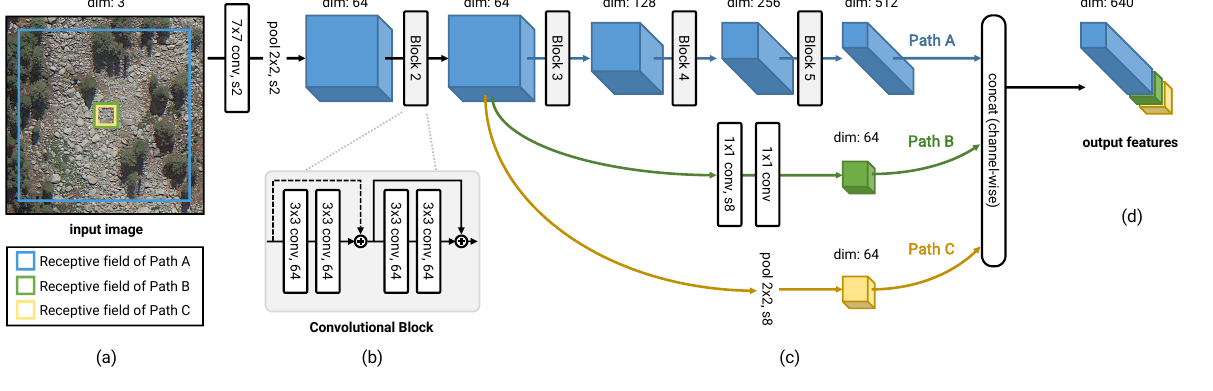
Figure 3. Architecture of the proposed Multi-Receptive Field network. This CNN has three different paths to output feature maps, each has its own receptive field. ( a ) The receptive fields of Path A and C are visualized as boxes. ( b ) The backbone is built using a residual convolutional block. ( c ) The three paths diverge from Block 2. Path B contains two 1 × 1 conv. layers. Path C contains only an average pooling layer. ( d ) The output feature maps are concatenated along the channel axis to compose the final